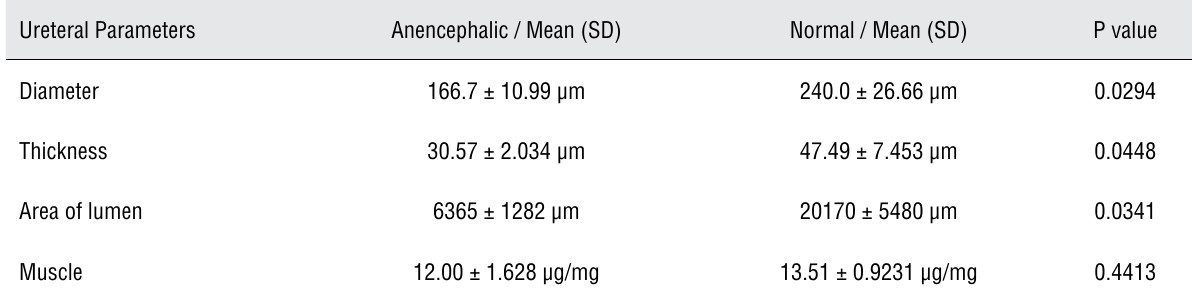
Table 2 - Statistical data of ureteral parameters analyzed.